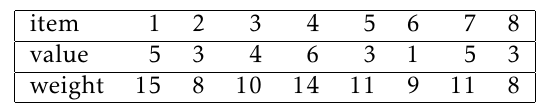
Table 1. Example of data for the